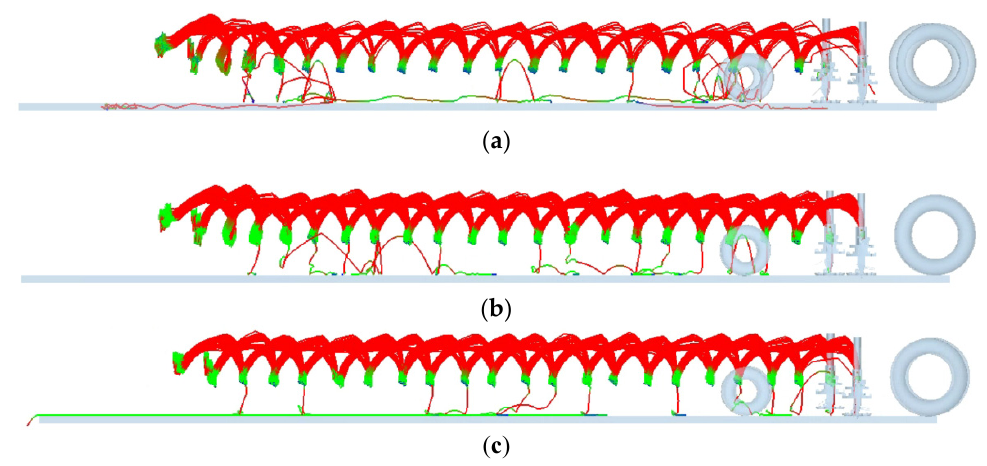
Figure 15. Effect of the maize shape on seeding performance. ( a ) Horse tooth. ( b ) Spherical cone. ( c ) Spherical. Note: the color of the maize seeds represents the movement speed, with red representing high speed, blue representing low speed, and green representing medium speed.